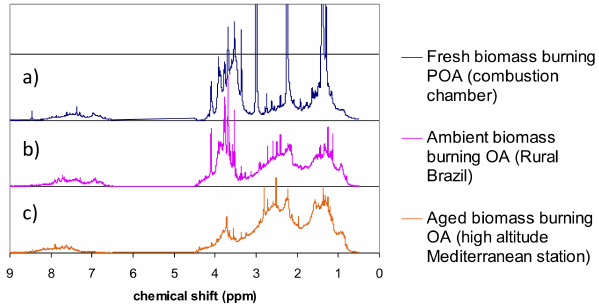
Figure 8. Reference 1 H-NMR spectra for different stages of biomass burning aerosol ageing: (a) laboratory wood burning POA (the sharp peaks at 1.3, 2.2 and 3.3ppm are from contaminants); (b) ambient near-source biomass burning aerosol; (c) biomass burn- ing aerosol from long-range